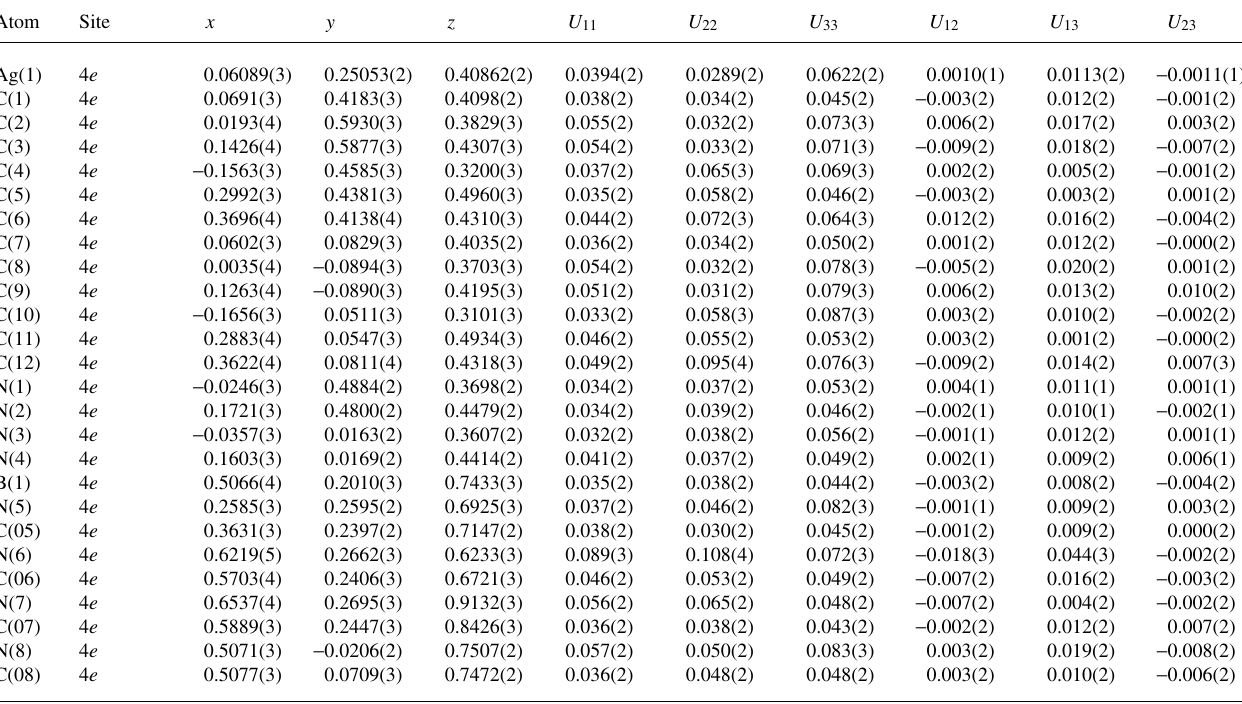
Table 3. Atomic coordinates and displacement parameters (in Å 2 )